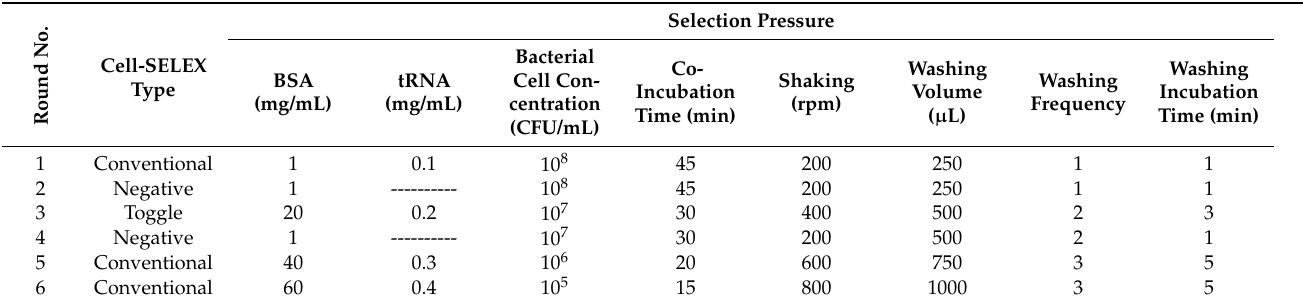
Table 2. Illustration of selection pressure applied throughout the enhanced Cell-SELEX procedure for selecting an aptamer specific for the three classic Brucella species; B. abortus , B. melitensis , and B. suis , reported in